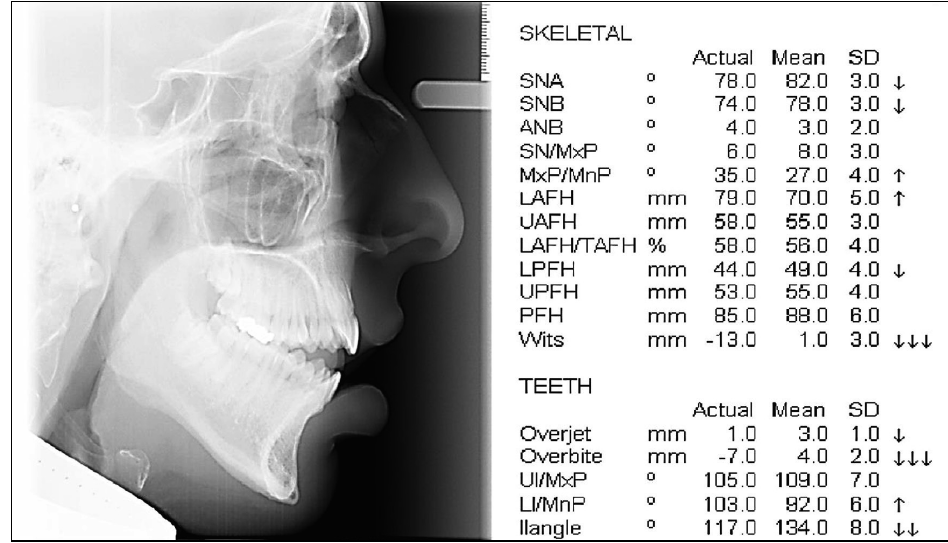
Figure 2. Pretreatment lateral cephalometric radiograph and analysis.